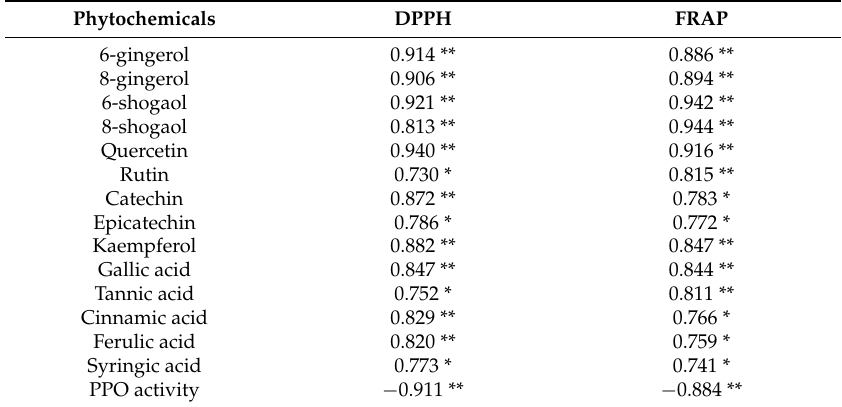
Table 4. Correlation analysis between identified phytochemicals and PPO activity with antioxidant activities of Z. officinale var. rubrum